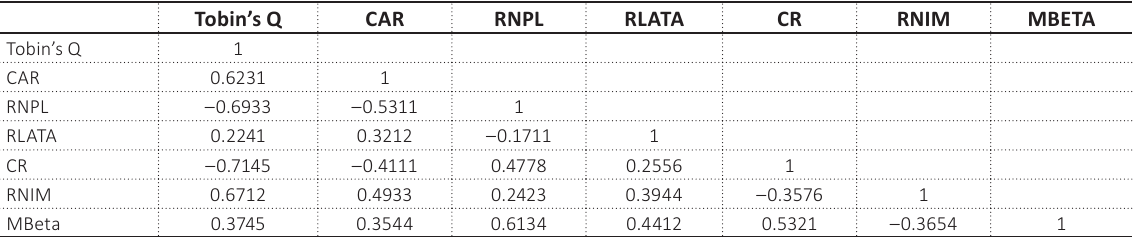
Table 6. Pearson correlation